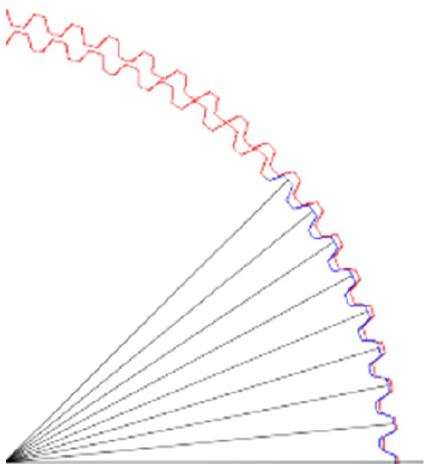
Figure 4. Center of the teeth of the designed flex spline.